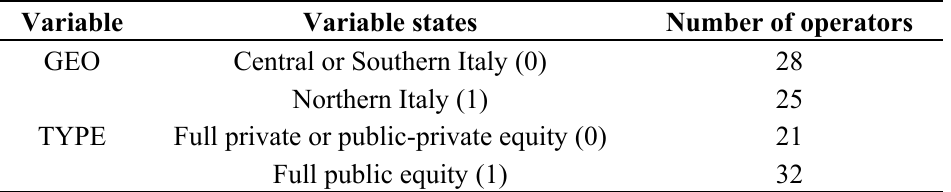
Table 5. Descriptive statistics of environmental (dichotomic)